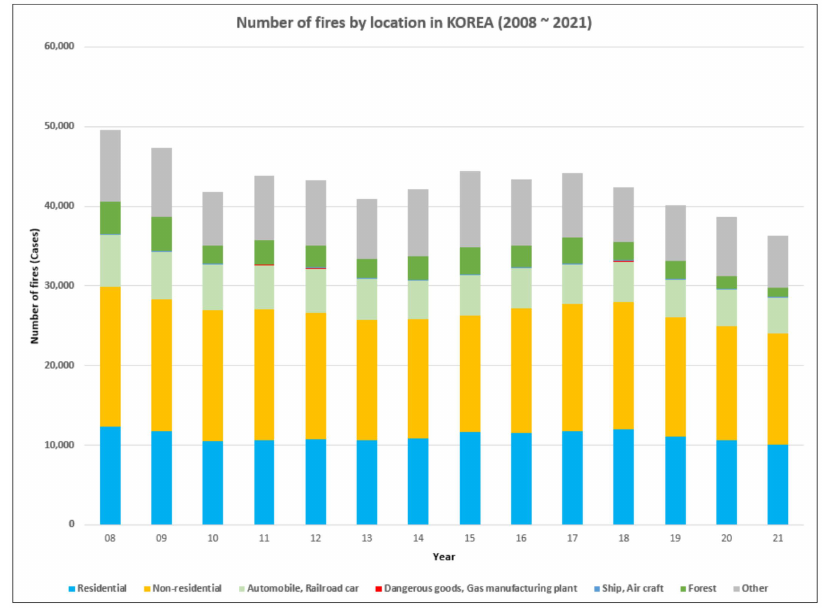
Figure 3. Number of fires by location in ROK